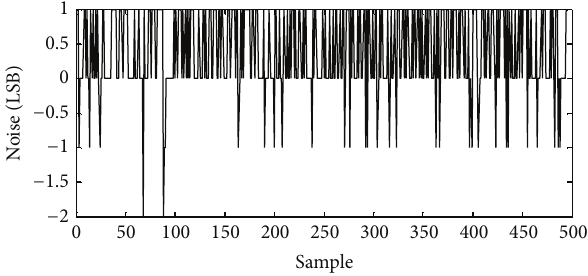
Figure 14: Measured ADC output noise with minimum input signal (500 sample points), indicating 0.6-LSB RMS noise floor and 74 dB dynamic